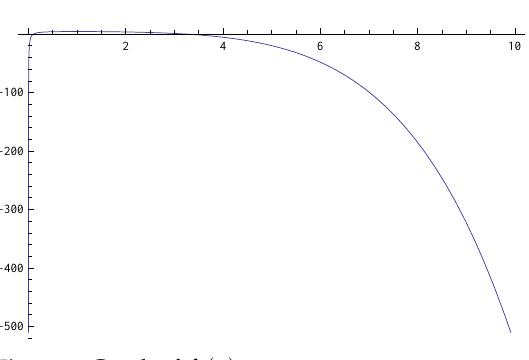
Figure 5. Graph of f 3 ( x ) .